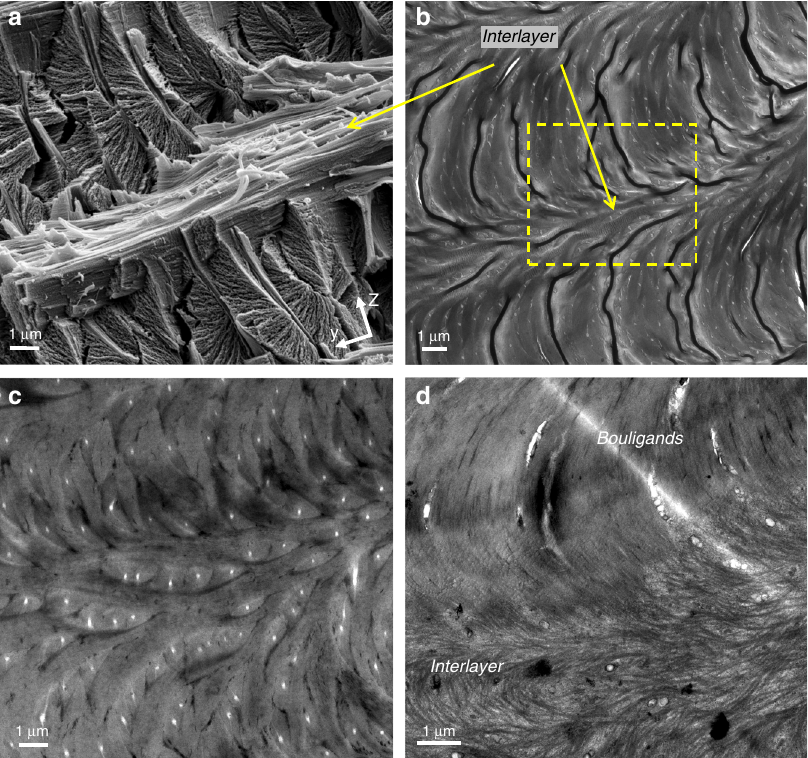
Fig. 3 Merging of BLU (Bouligand laminate unit) fi bers into the interlayer. YZ transversal view. a SEM image of an interlayer separating two BLU layers, and b , c TEM images of the same region. The tiny white dots are cross-sections through the pore canal fi bers. d Magni fi ed TEM image of the squared region showing fi bers merging into an interlayer.